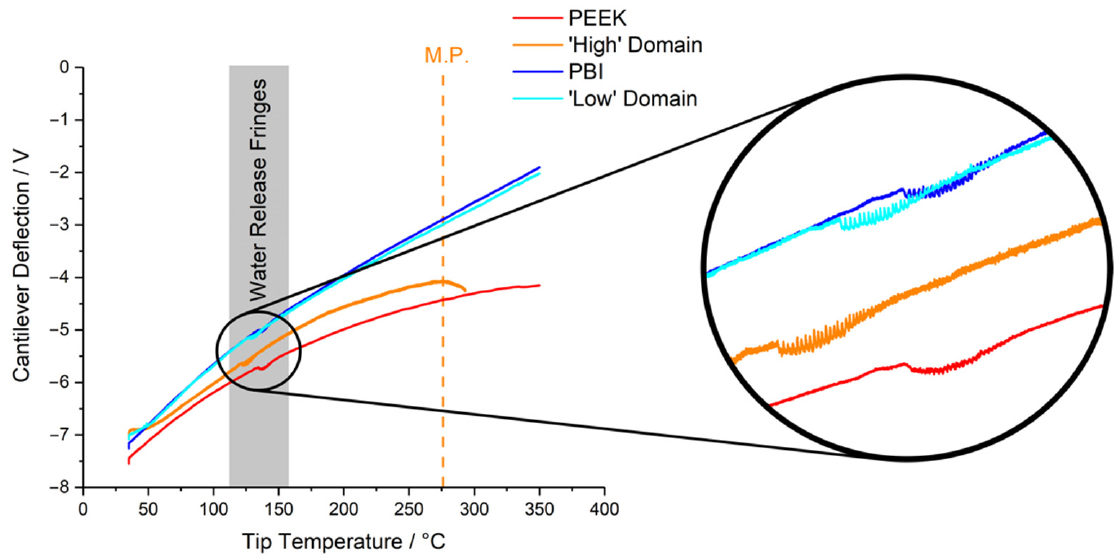
Figure 6. NanoTA deflection profiles for pure PEEK, pure PBI, and from the ‘high’ and ‘low’ domains of PPB, taken at least 5 µ m distant from the boundary showing the regions of water release fringes in the inset.